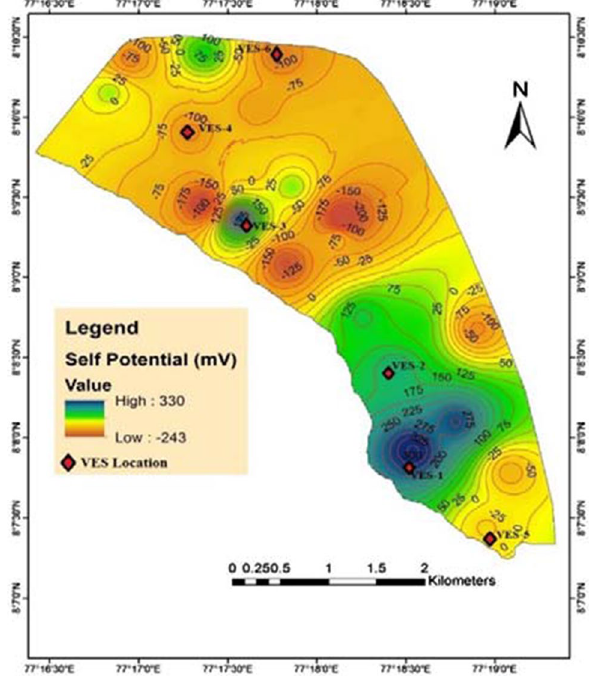
Fig. 14 Spatial distribution and contour map of